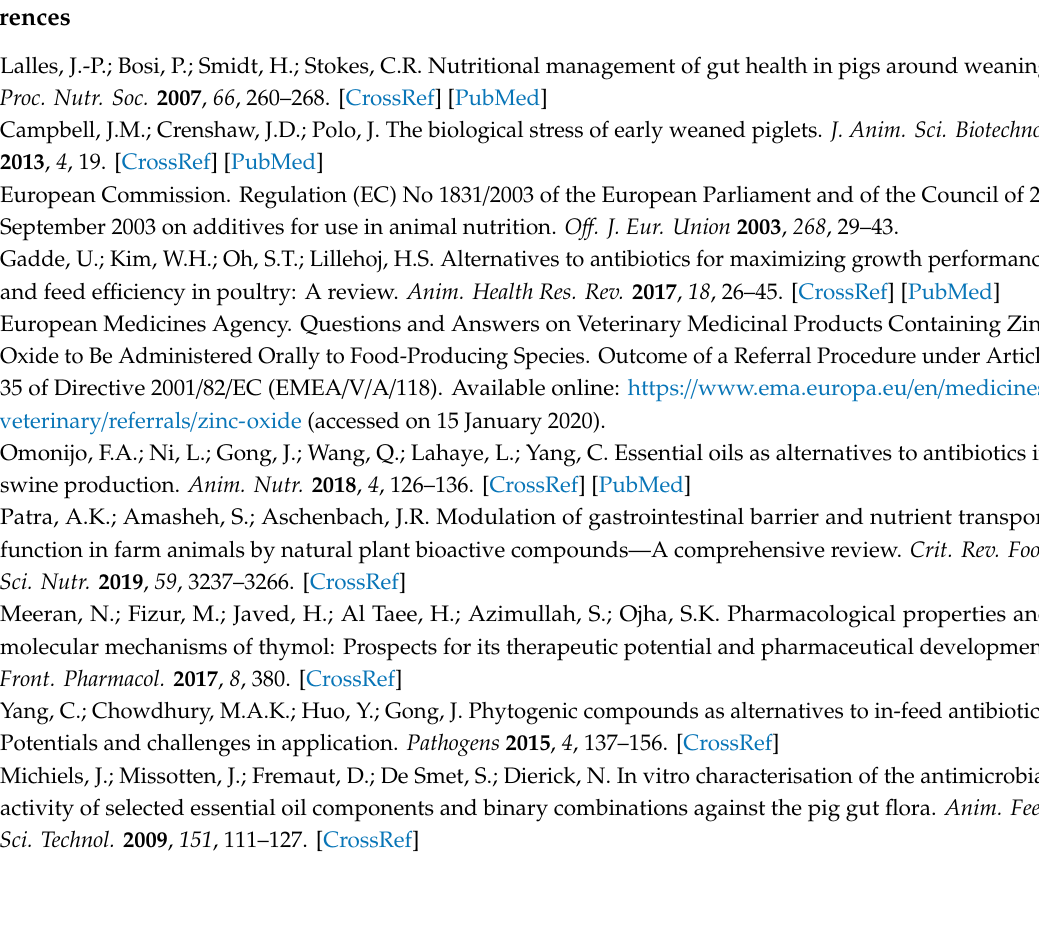
Figure S1: Schematic overview of the allocation; Figure S2: Bacterial community compositions present in the digesta of the last 25% of the small intestinal length for each individual pig. The cumulated histograms show the relative abundance of the identified taxa at the ( a ) phylum, ( b ) family, and ( c ) genus